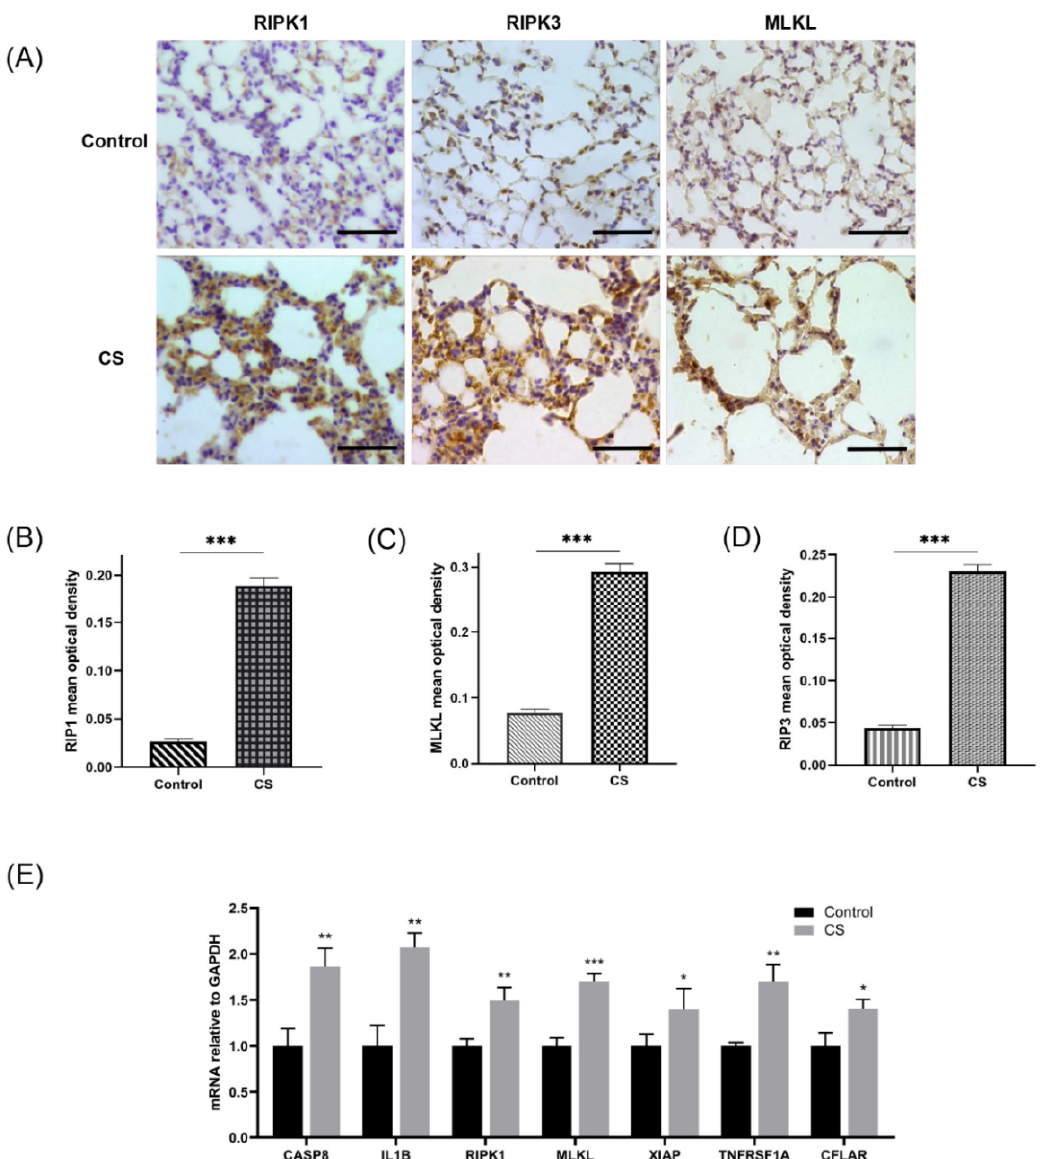
Figure 9. Assessment of necroptosis in lung tissues of experimental mice. ( A ) Photomicrograph of slides of tissues from mice in the normal control group and CS group immunohistochemically stained for RIPK1, RIPK3, and MLKL (400 × magnification). Scale bar = 50 µ m. ( B ) Quantification of RIPK1 ( n = 6). ( C ) Quantification of RIPK3 ( n = 6). ( D ) Quantification of MLKL ( n = 6). ( E ) Relative mRNA expression levels of necroptosis-related hub genes in lung tissues ( n = 4). * p < 0.05, ** p < 0.01, *** p < 0.001.